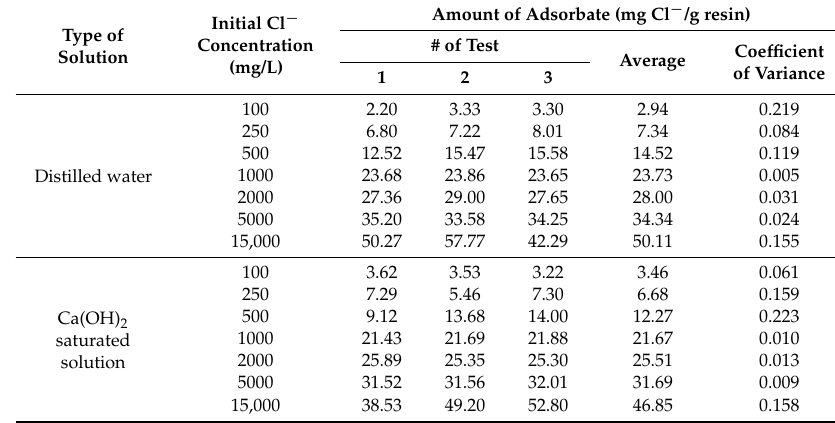
Table 8. Experimental results of the equilibrium